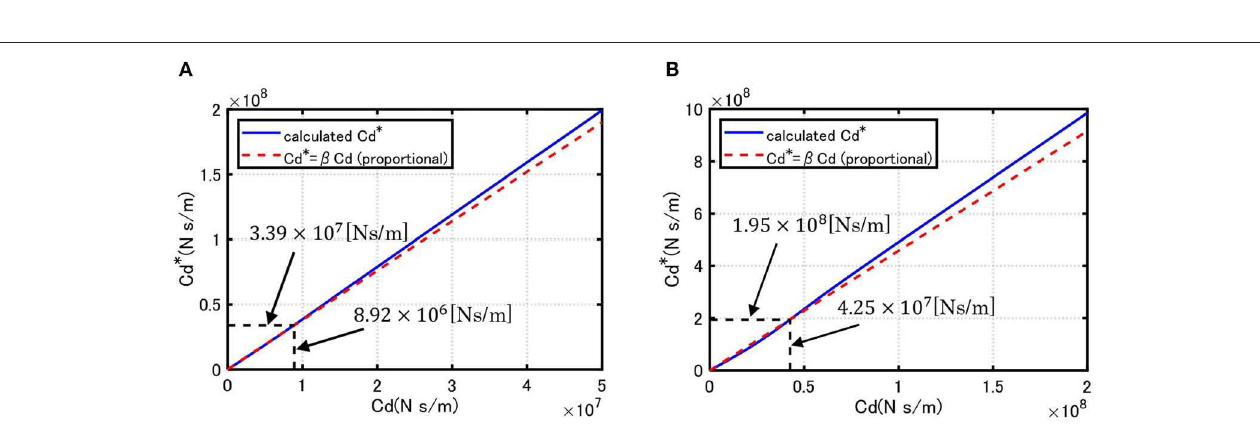
FIGURE 5 | Relation of original damping coefficient of viscous damper in MDOF model and damping coefficient of viscous damper in equivalent SDOF model. (A) Original Model ( β = 3.80) and (B) Stiffer Model ( β = 4.58).